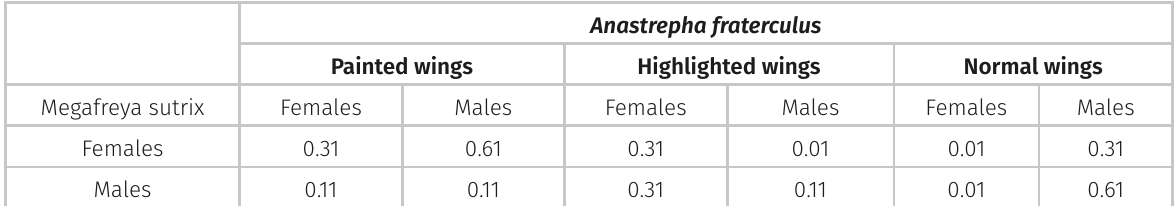
Table II. Predation of the treatments Anastrepha fraterculus off bands, highlighted bands and normal wings by both sexes of Megafreya sutrix through the Chi-square test with Yates correction for continuity, probability